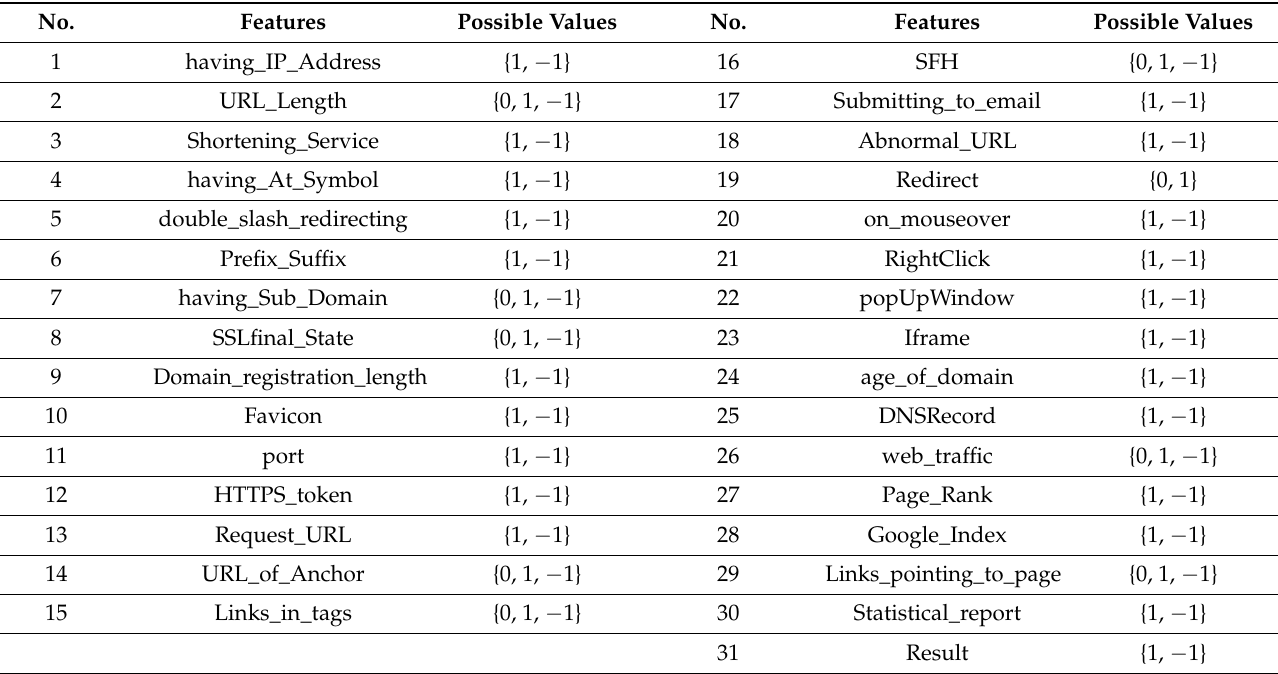
Table 5. Features of Dataset-1.